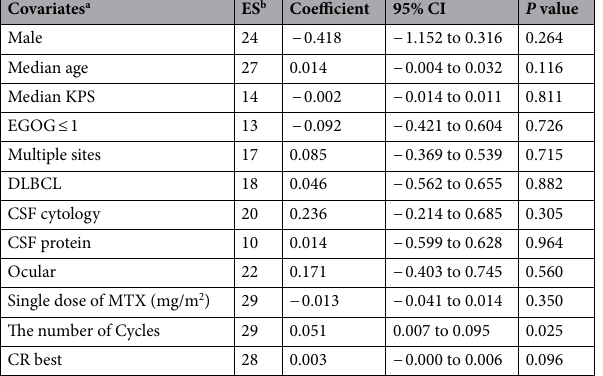
Table 2. Meta-regression analysis of the heterogeneity of the basic characteristics. ES effect size, CI confidence interval. a All of the data in this analysis are presented in Table 1. b Number of studies used in the regression